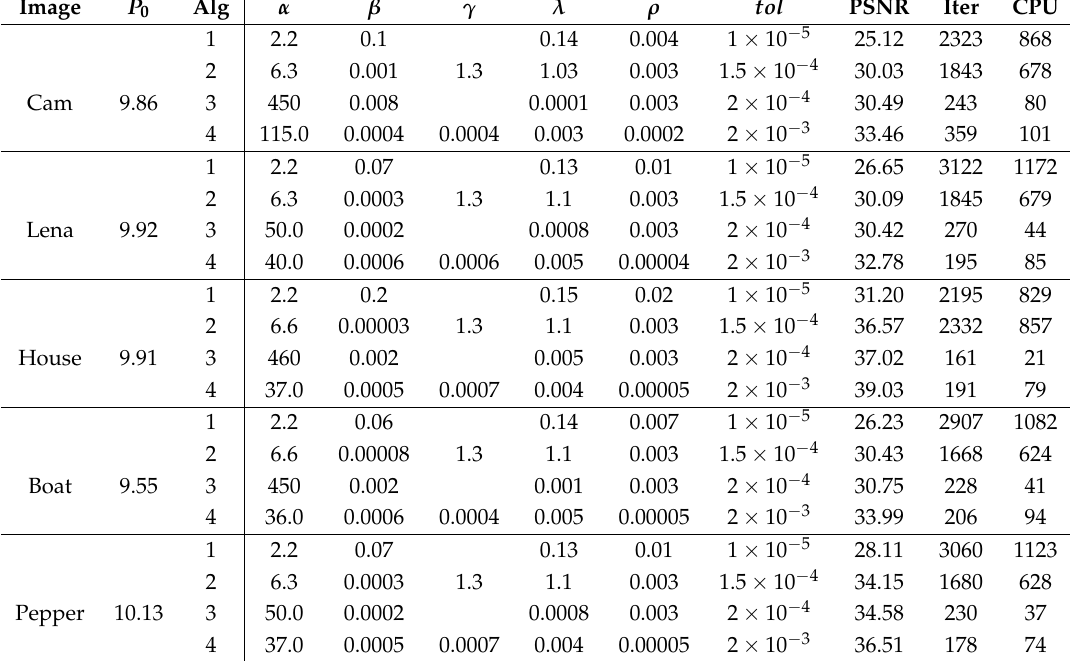
Table 2. Numerical results for TVL1 problems with 30% salt-and-pepper impulse noise.